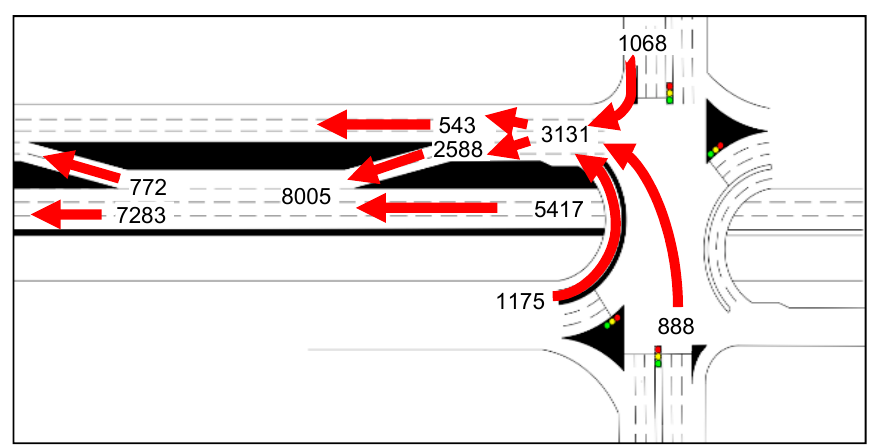
Figure 3. Summary of traffic volume during peak hour.